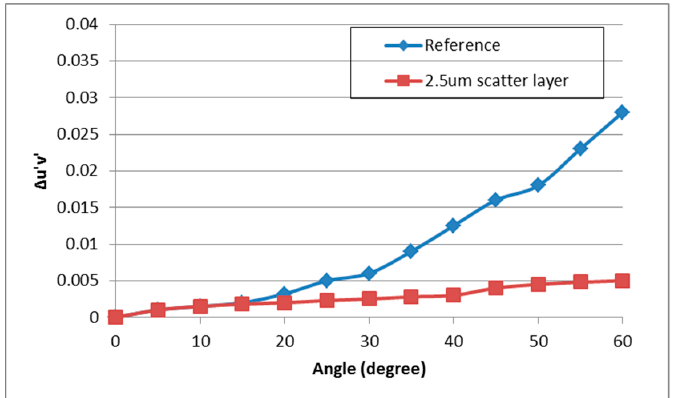
Figure 7. Change of color coordinates ( ∆ u’v’) of the OLED device with the implemented 2.5 µ m thick YSZ nanoparticle scattering layer versus the viewing angle.